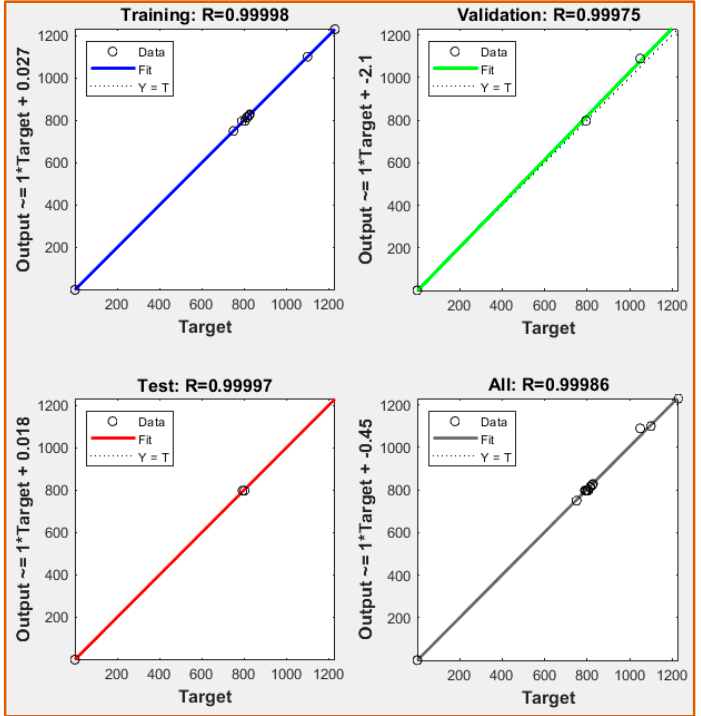
Figure 14. Regression graphs for the developed ANN network depicting training, validation, and